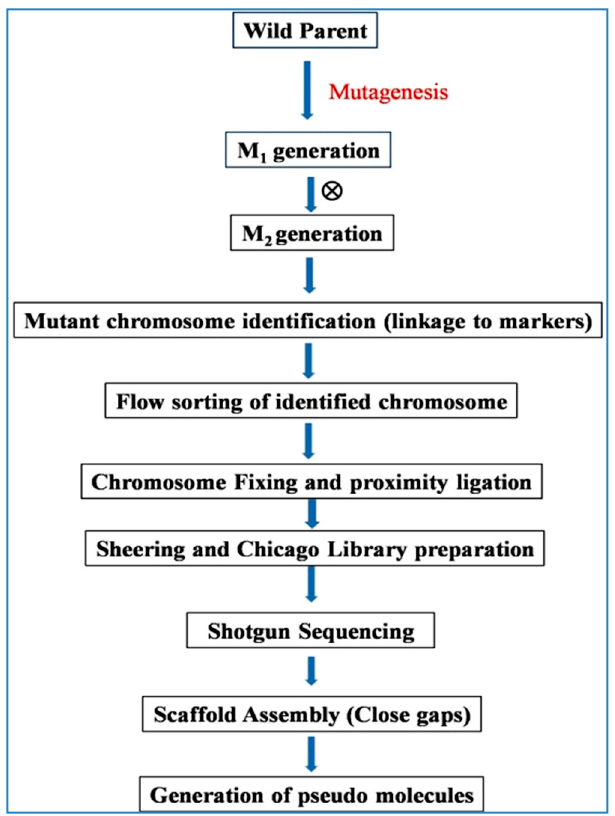
Figure 8. Flow diagram showing the major steps of TACCA (Targeted chromosome-based cloning via Long-range assembly) approach of forward genetic screen.